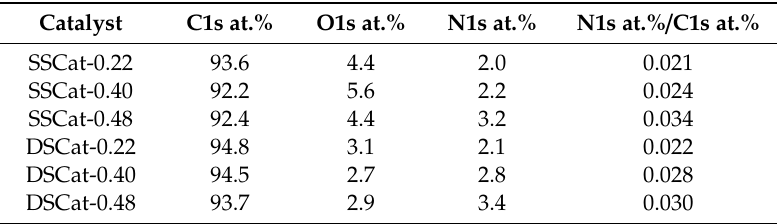
Table 3. XPS semi-quantitative analysis recorded for the catalysts.